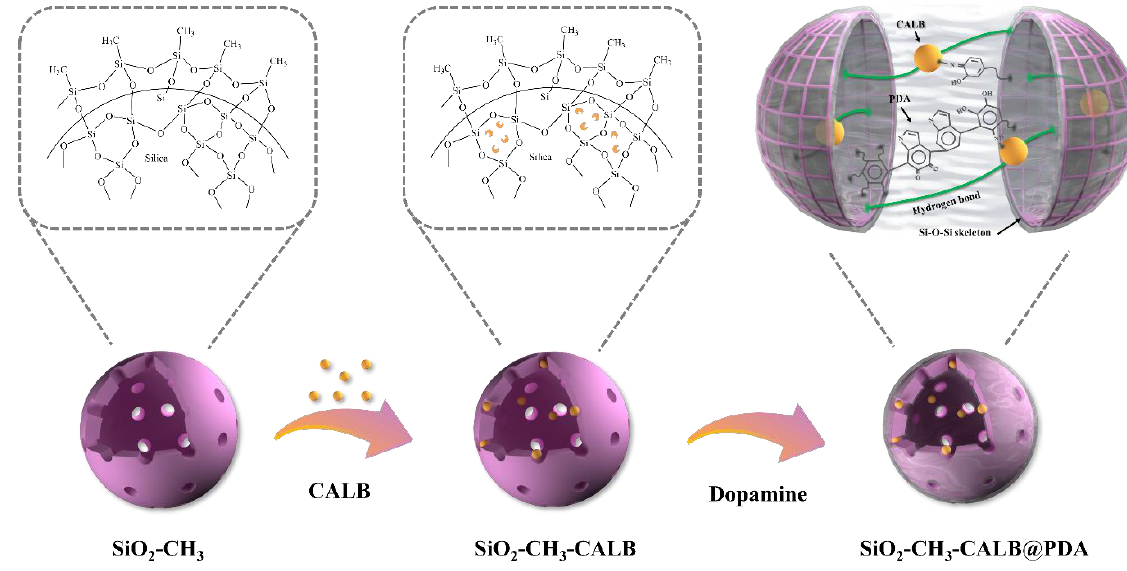
Figure 5. The internal microstructures of SiO 2 –CH 3 –CALB and SiO 2 –CH 3 –CALB@PDA and the possible mechanism of the polydopamine-modified immobilized enzyme.